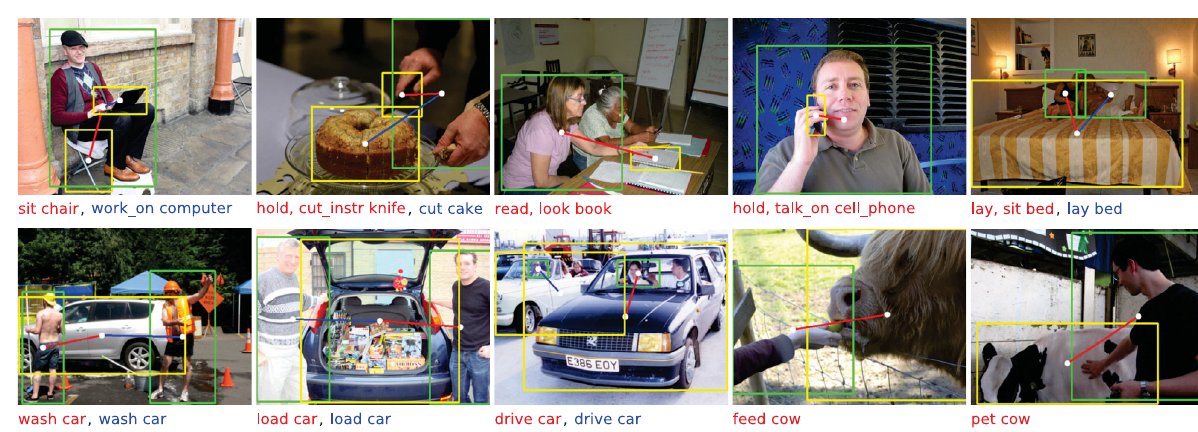
Fig. 4 HOI detection examples from V-COCO (above) and HICO-DET (below). Green boxes: humans. Yellow boxes: objects. Interaction is indicated by a colored line between human and object center